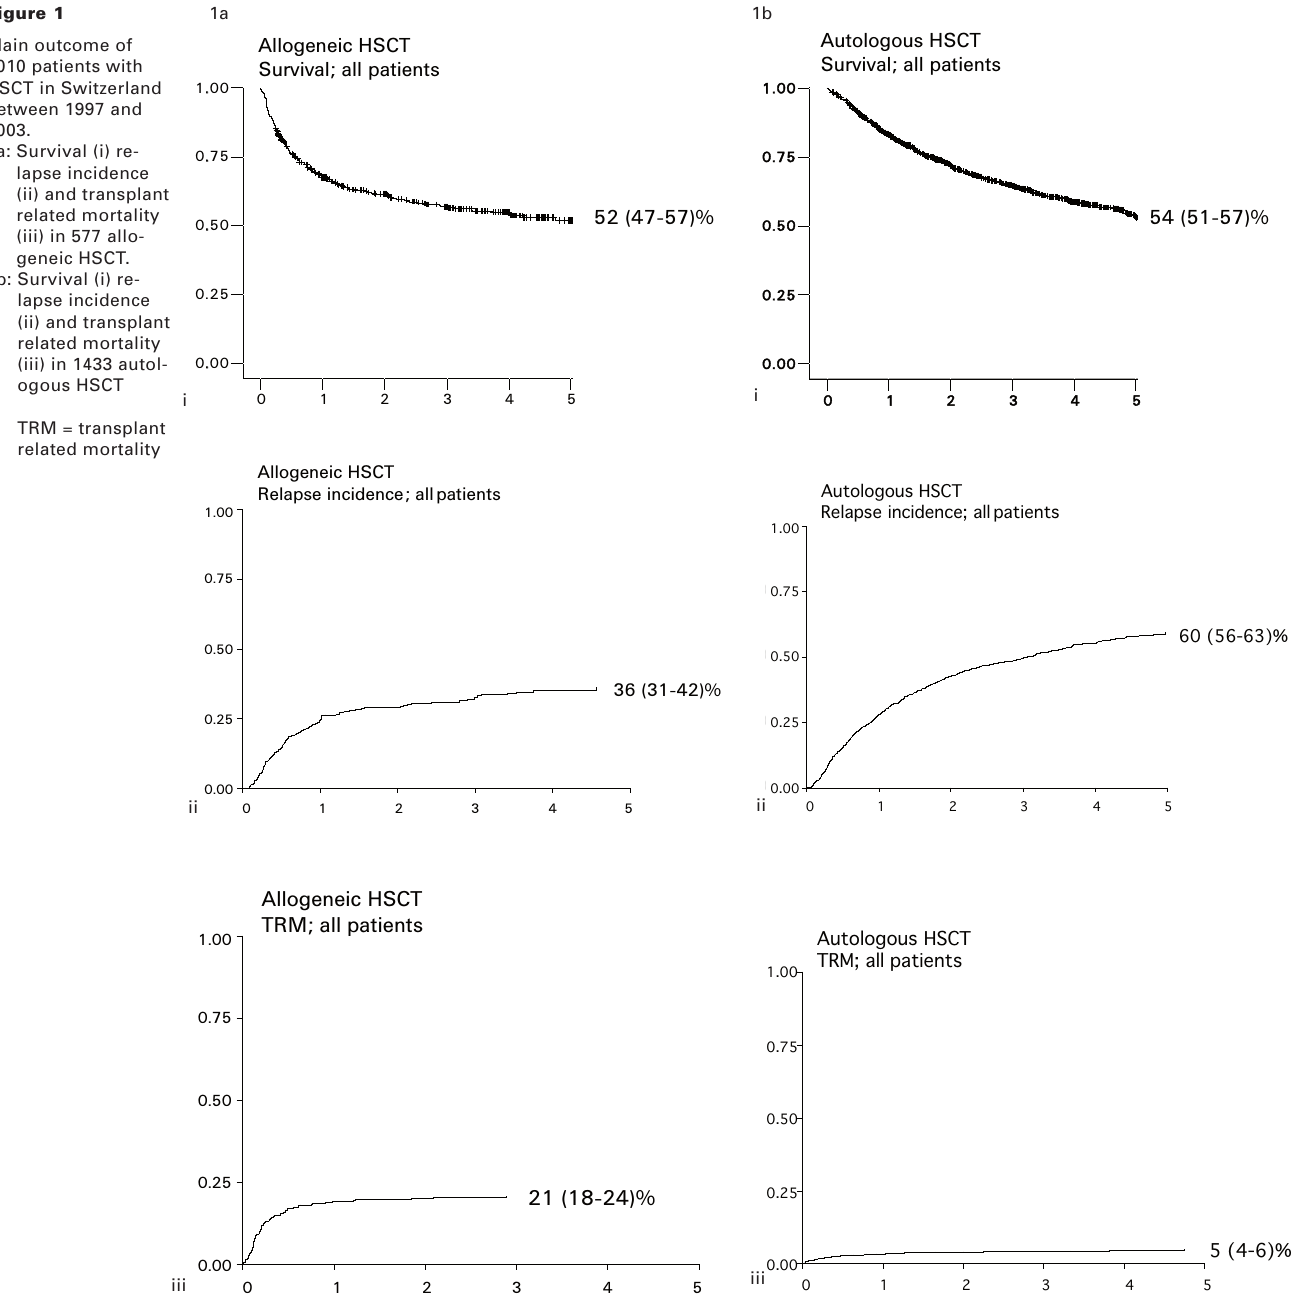
Figure 1 Main outcome of 2010 patients with HSCT in Switzerland between 1997